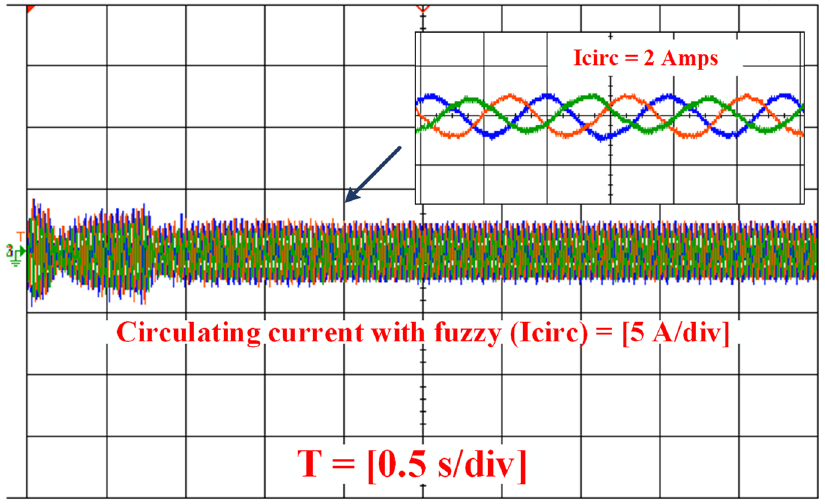
Figure 22. MMC circulating currents with fuzzy logic controller.